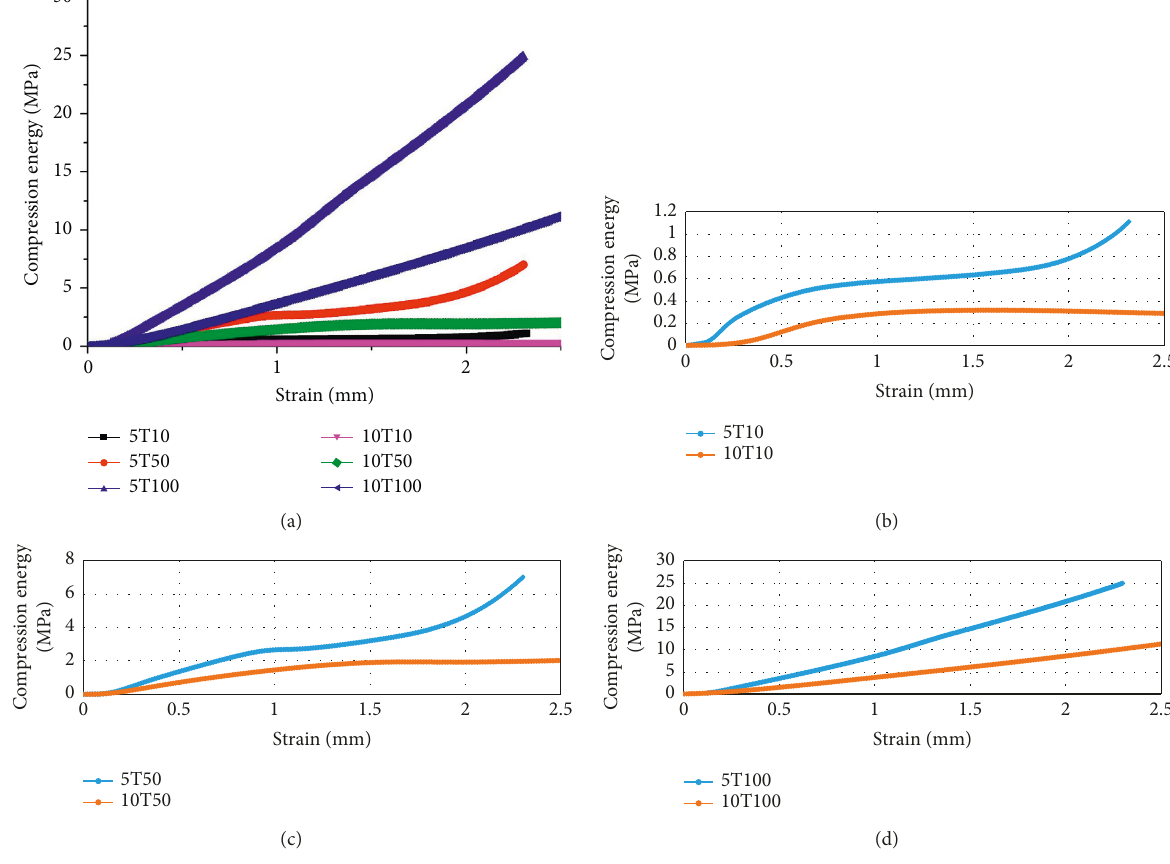
Figure 5: Compressibility property in relation to thickness with 10%, 50%, and 100% infill rates.